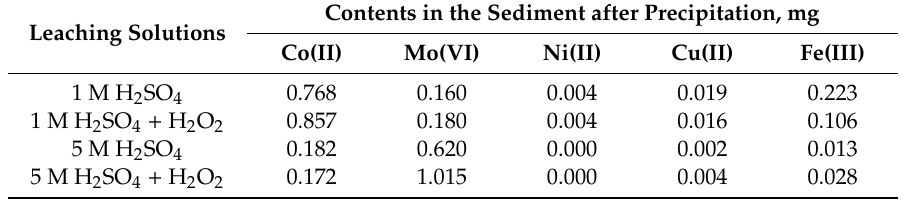
Table 2. Metal content in the selected deposits after precipitation with 30% NaOH